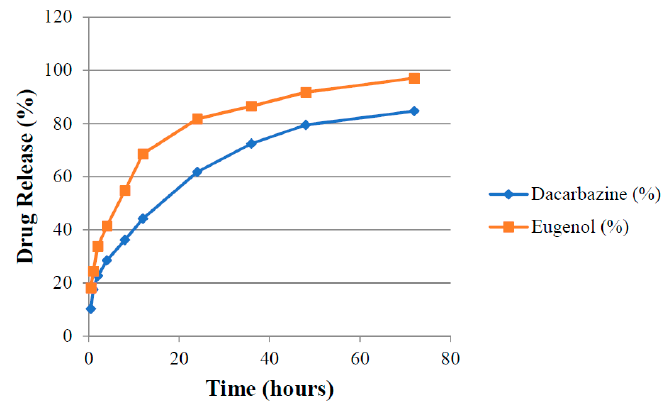
Figure 11. Cumulative release of Dacarbazine and Eugenol from hyaluronic acid (HA)-coated Figure11. CumulativereleaseofDacarbazineandEugenolfromhyaluronicacid(HA)-coatedliposomes. liposomes.